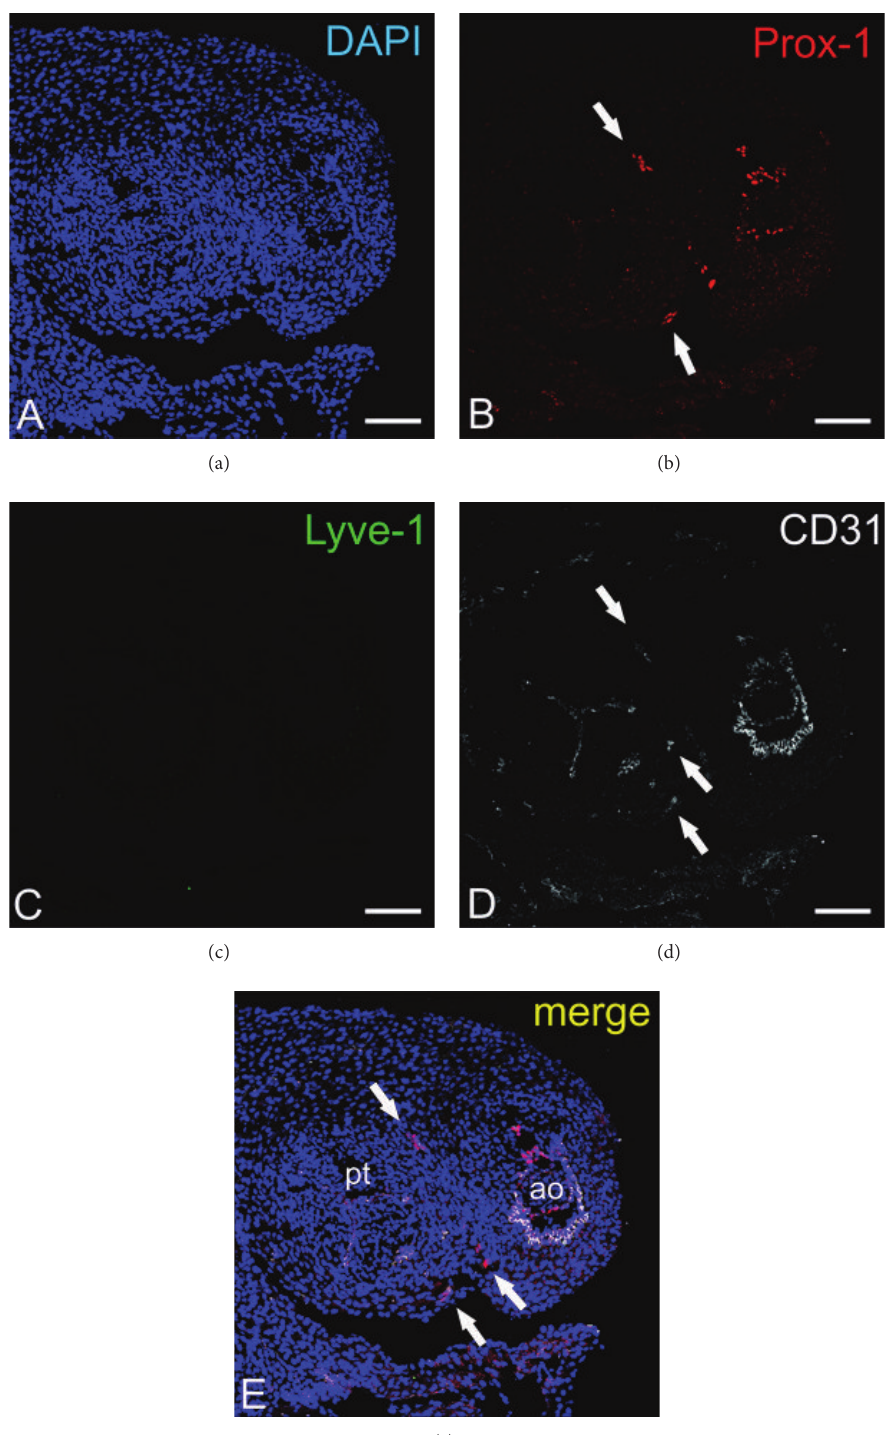
Figure 2: Confocal microscopy images of a 13-dpc mouse heart stained with DAPI (blue), anti-Prox-1 (red), anti-Lyve-1 (green), and anti- CD31(white).Prox-1 + /CD31 + /Lyve-1 − vessels(whitearrows)arepresentalongthegreatarteries;ao—aorta;pt—pulmonarytrunk;scalebars = 100 𝜇